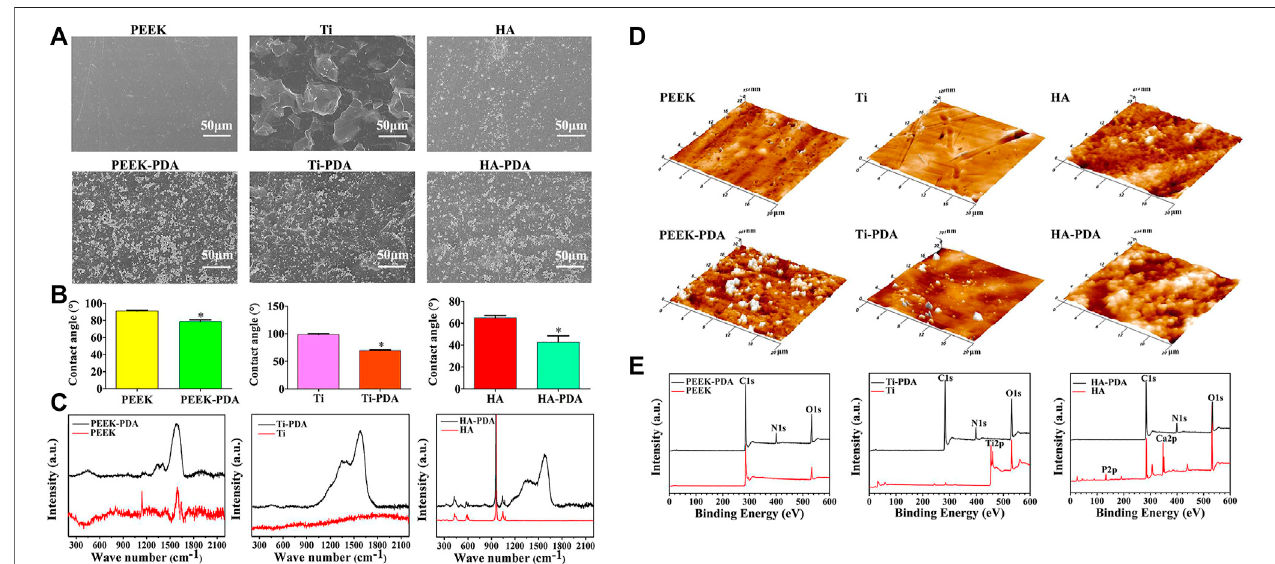
FIGURE 4 | Changes of surface physiochemical property after PDA modi fi cation on different biomaterials. Changes of surface morphology observed by (A) SEM and (D) AFM images; (B) Changes of surface wettability; Changes of chemical conponents detected by (C) Raman spectra and (E) XPS analysis, the characteristic peaks of PDA can be observed (Wang H. et al., 2019). Copyright 2019, American Chemical Society.